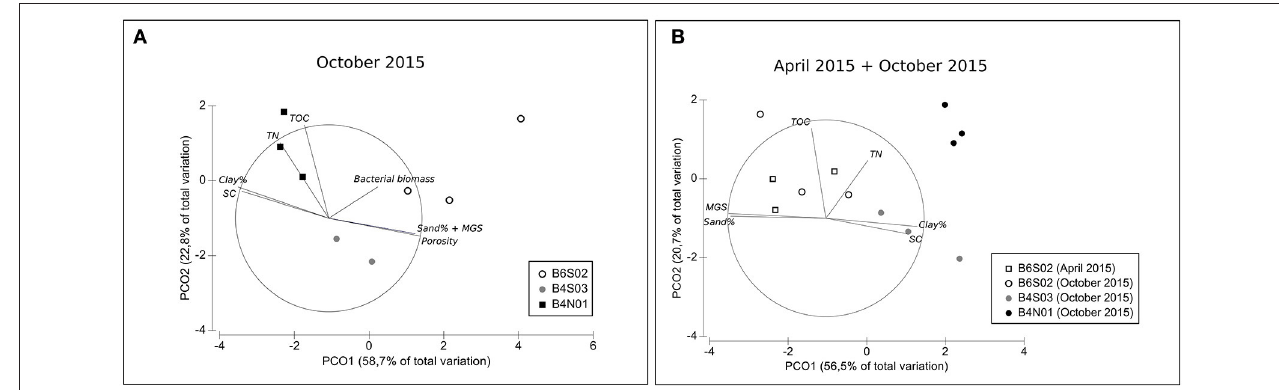
FIGURE 2 | PCO plots of sediment-depth integrated (0–5cm) environmental variables for all three sites sampled in the GSR license area (A) during GSRNOD15A (October 2015, all sites) and (B) during GSRNOD15A (October 2015, all sites) and SO239 (April 2015, site B6S02). MGS, median grain size; SC, sediment sorting coefficient; TN, total nitrogen content; TOC, total organic carbon content. Vectors represent sediment characteristics correlating > 50% (based on Spearman correlation coefficients) with one of the two PCO axes. Note that in the second PCO analysis (B) sediment porosity and bacterial biomass were excluded from the analysis as these variables were not measured on samples collected in April 2015.